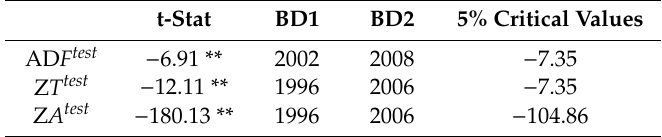
Table 5. Results of the Hatmi-J (2008) cointegration test with two break dates. t-Stat BD1 BD2